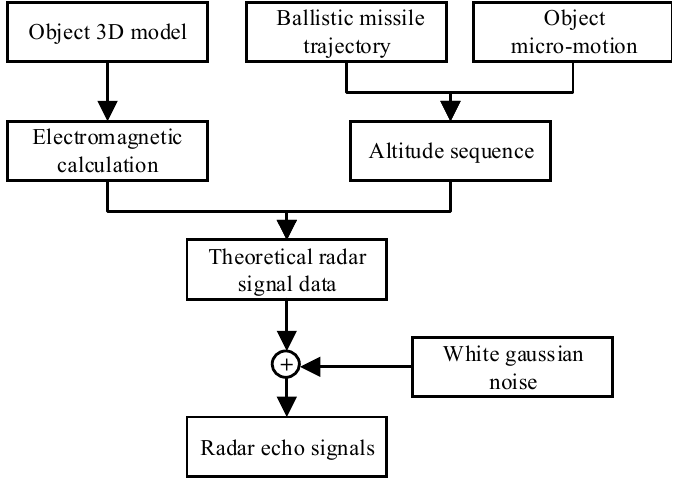
Figure 5. Normalized HRRPs of three models for 𝜑 ∈ [0 ° , 180 ° ] : ( a ) HRRPs of cone; ( b ) HRRPs of cone plus cylinder; ( c ) HRRPs of cylinder.